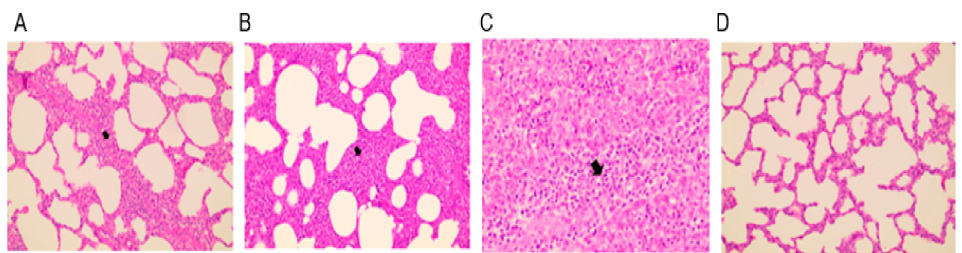
Figure 6. Histopathological lesions in the lungs of experimental animals. ( A ) E38-ORF7 CPD intramuscular group (V/IM/Challenge Virus): alveoli show mild hyperplasia and cell accumulation. ( B ) E38-ORF7 CPD intradermal group (V/ID/Challenge Virus): the alveolar septum is slightly thicker than in animals that received the vaccine intramuscularly. ( C ) UnVac/Ch (Positive control): the alveolar septum is thickened with accumulation of necrotic debris and inflammatory cells. ( D ) UnVac/UnCh (Negative control): alveoli and the alveolar septum are clear and normal. The differences were found to be statistically significant ( p < 0.05) between the vaccinated group and the positive control (unvaccinated challenged